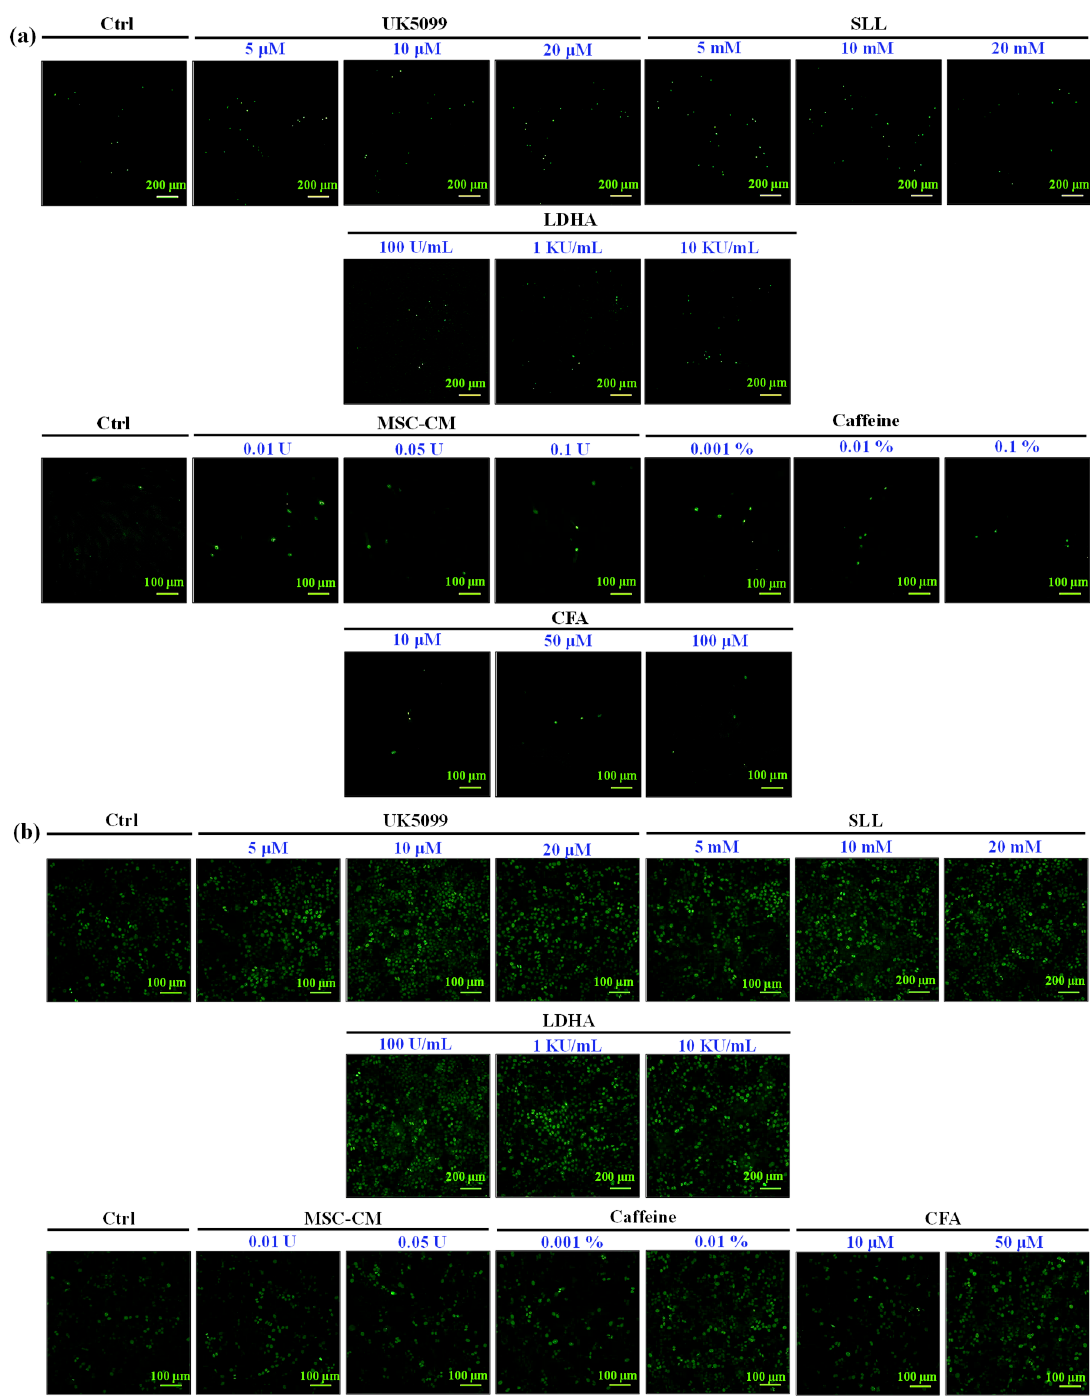
Figure 3. Ki67 staining of ( a ) HFMSC and ( b ) HaCaT after being treated with different kinds of drugs. More Ki67 positive cells were observed in both the HFMSCs and HaCaT treated samples.